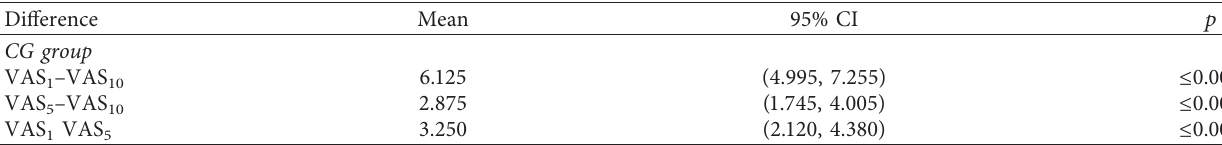
Table 3: Results of Tukey HSD test for the CG group.